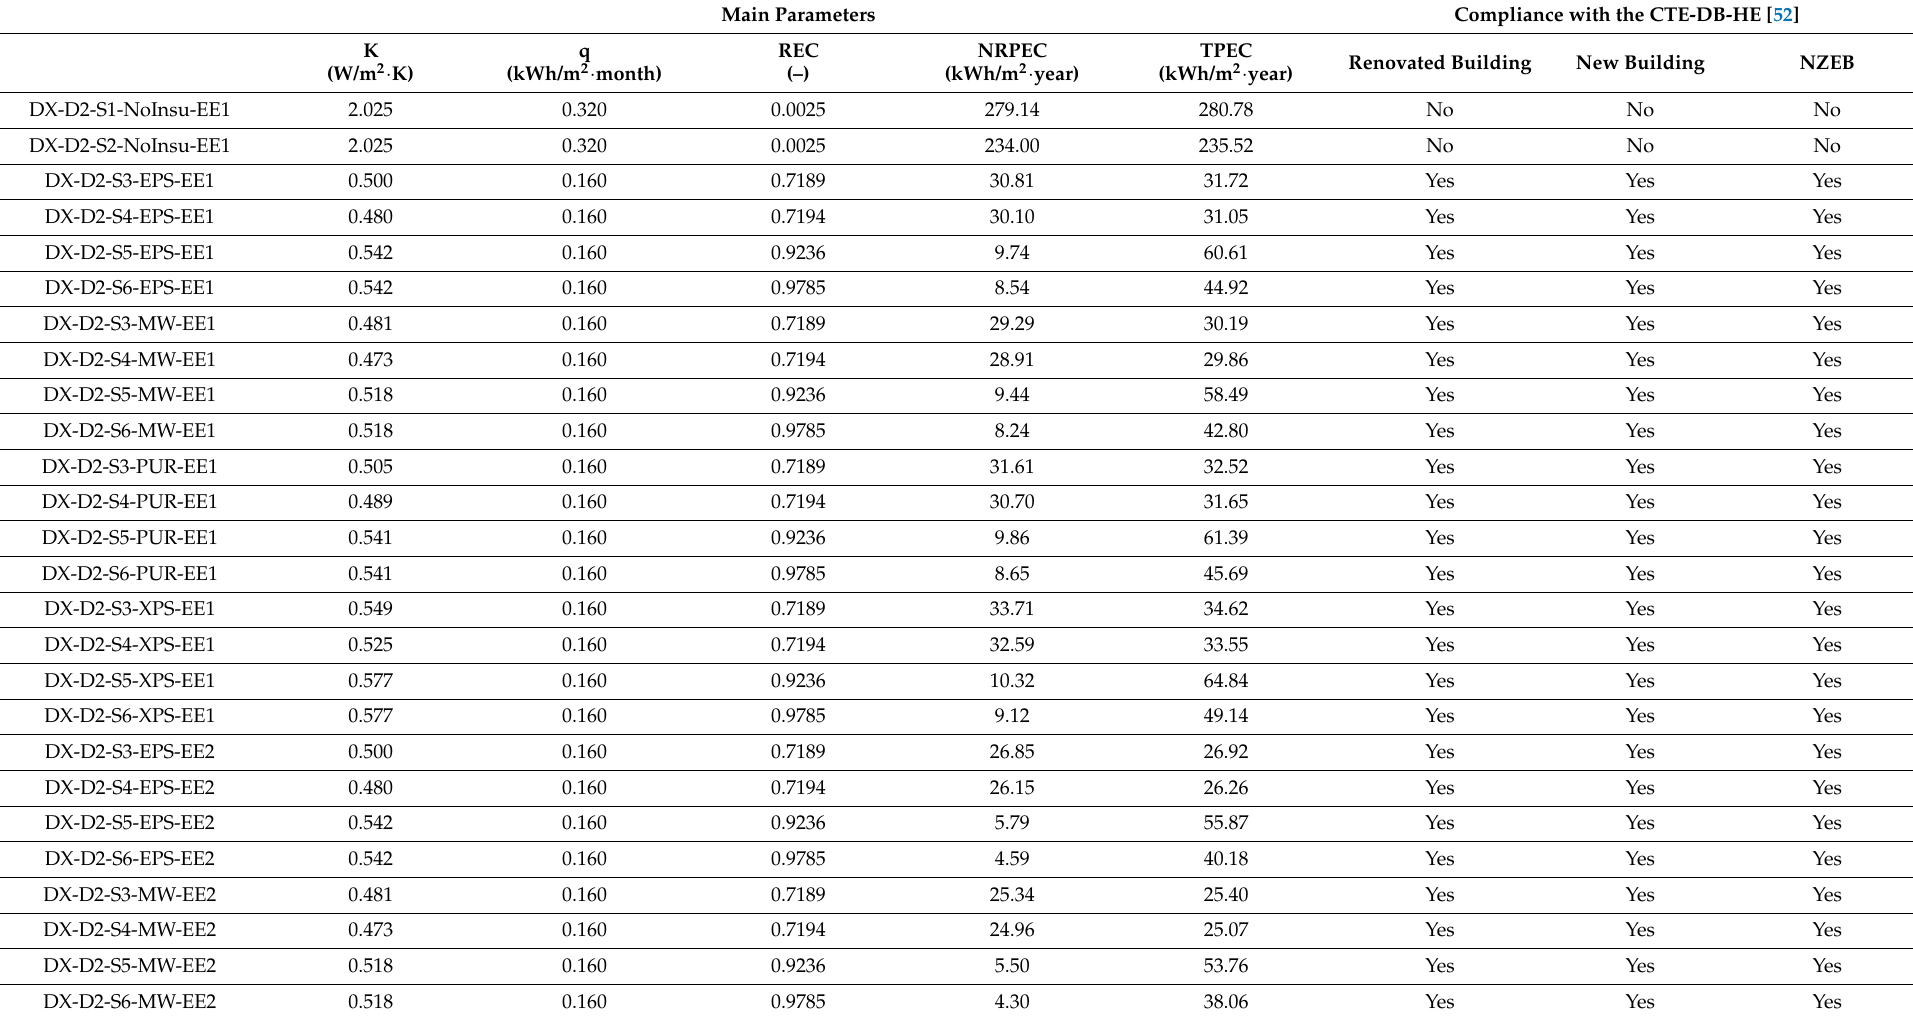
Table A2. Verification of compliance with the CTE-DB-HE [52] for each case study in Cervera del R í o Alhama (CCZ DX-D2). Main